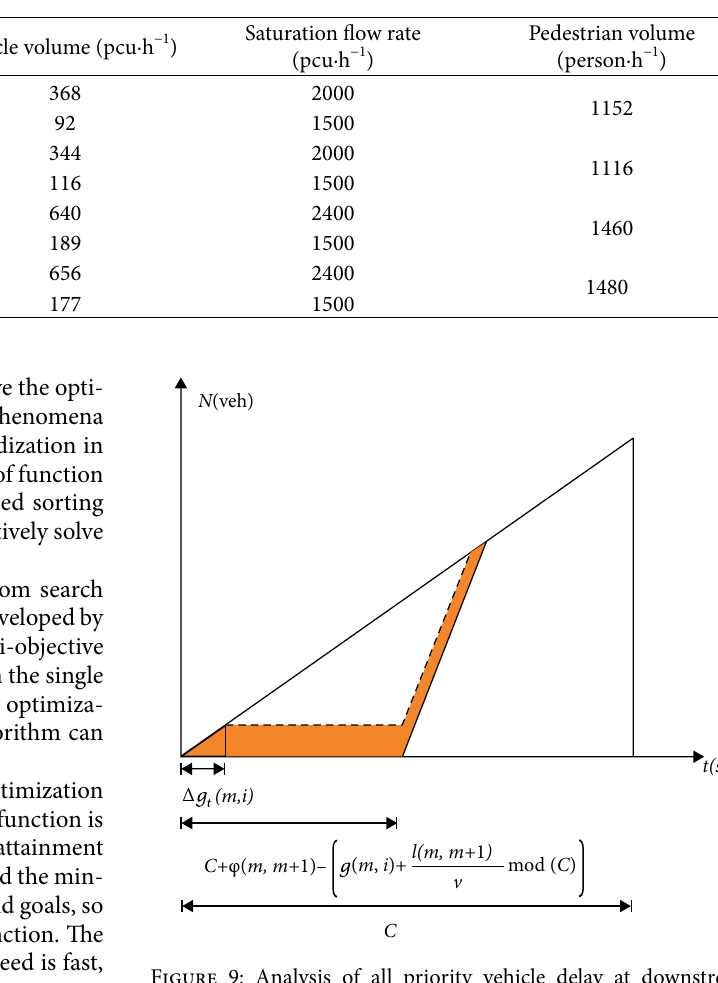
Table 2: Basic parameters of intersections during peak period.